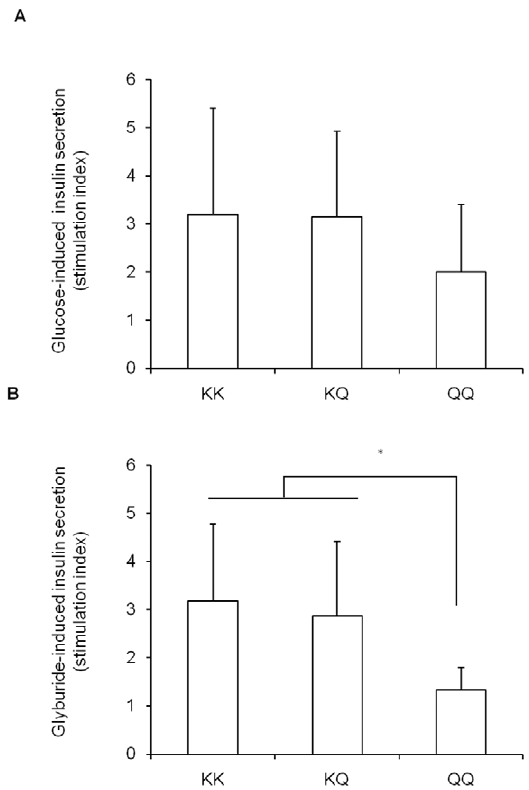
donors. Insulin secretion stimulated by glucose (16.7 mM, ( A )) or glyburide (100 m M, ( B )) was measured on isolated human islets as described in methods. Islets from QQ donors (n=2) tended to secrete less insulin than islets from KK (n=59) and KQ (n=24) individuals under both conditions. Data (mean 6 SEM) are expressed as stimulation index calculated by dividing stimulated insulin release (either by glucose 16.7 mM ( A ) or by glyburide 100 m M ( B )) over basal insulin release (at glucose 3.3 mM).